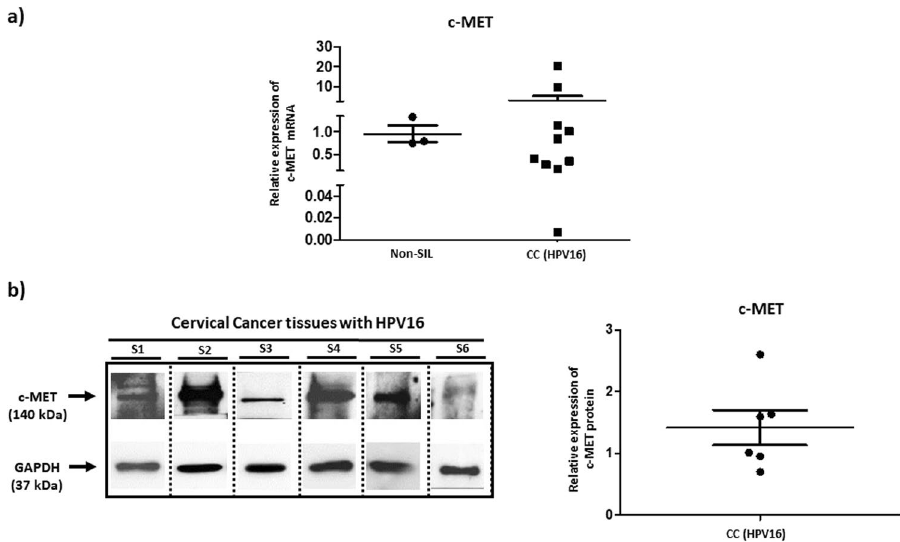
Figure 6. Levels of c-Met expression in CC tissue. (a) Level of relative c-Met expression in cervical scraping samples taken from non-SIL patients and in CC tissues, determined via RT-qPCR. The expression of c-Met mRNA is higher in CC tissues than in non-SIL scraping samples. The levels of c-Met expression were normalized with those from GAPDH and analyzed via the Δ Ct method. The comparison among groups was undertaken via the Mann Whitney test. (b) The expression of the c-Met protein was heterogenous in CC tissues. The image from the Western Blot assay was constructed based on bands located in different positions in the same membrane and independent assays. The expression of c-Met was normalized with the expression of GAPDH protein. S: